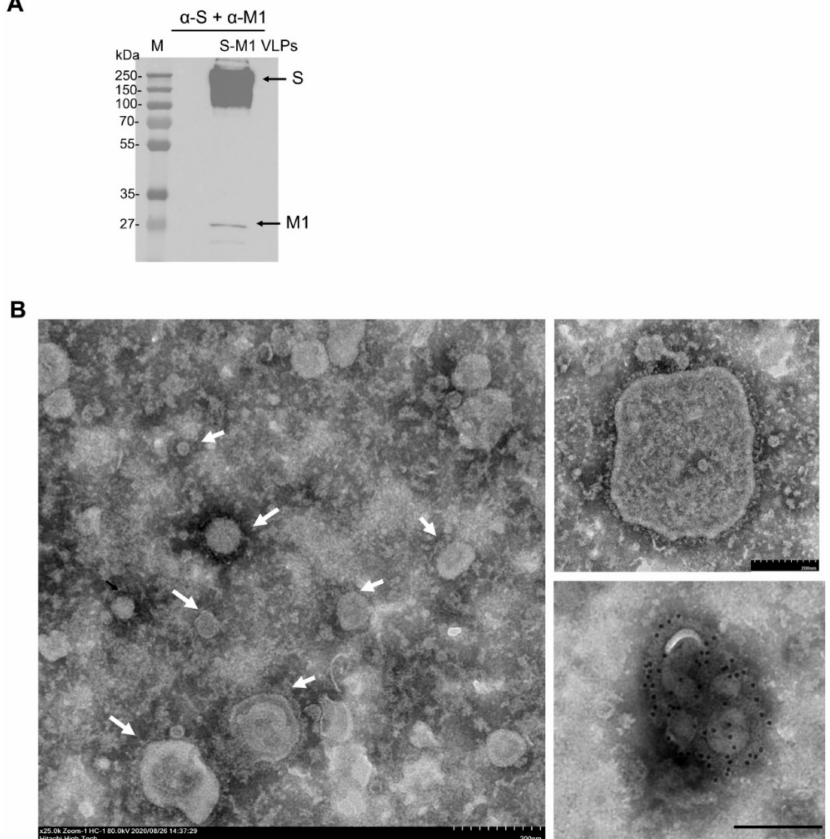
Figure 3. Characterization of S-M1 VLPs. ( A ) Purified VLPs were lysed and analyzed by Western blotting using rabbit α -S or mouse α -M antibodies. Goat α -rabbit or α -mouse IgG HRP were used as secondary antibodies. ( B ) Purified VLPs were negatively stained with the phosphotungstic acid solution. Particles were incubated with rabbit α -S antibodies followed by gold-conjugated α -rabbit antibodies for immunogold labeling. Particles were visualized by TEM. Scale bars are 200